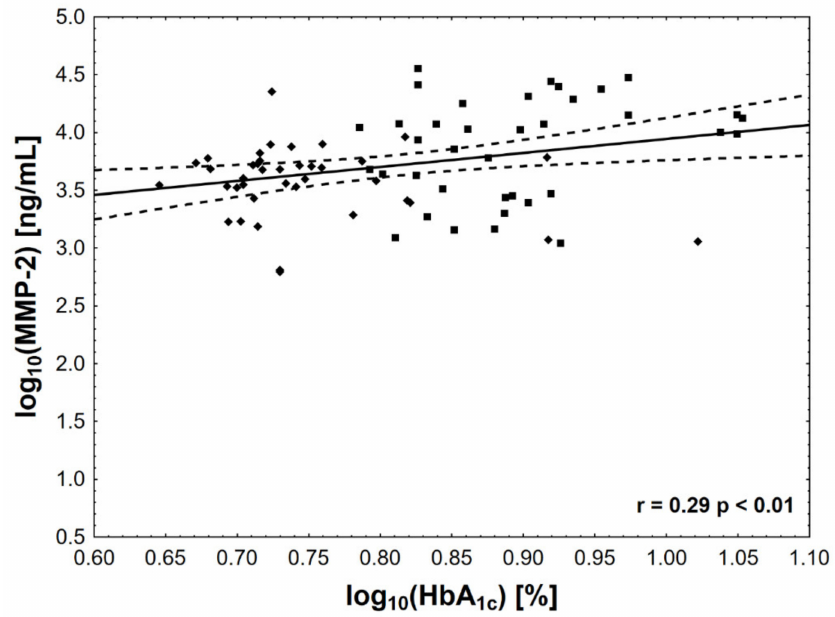
Figure 2. The associations between HbA 1c concentration and MMP-2 activity. The value of log HbA 1c of 0.78 corresponds to HbA 1c level = 42 mmol/mol (6.0%), log HbA 1c of 0.9—to HbA 1c level = 64 mmol/mol (8.0%), and log HbA 1c of 1.0—to HbA 1c level = 86 mmol/mol